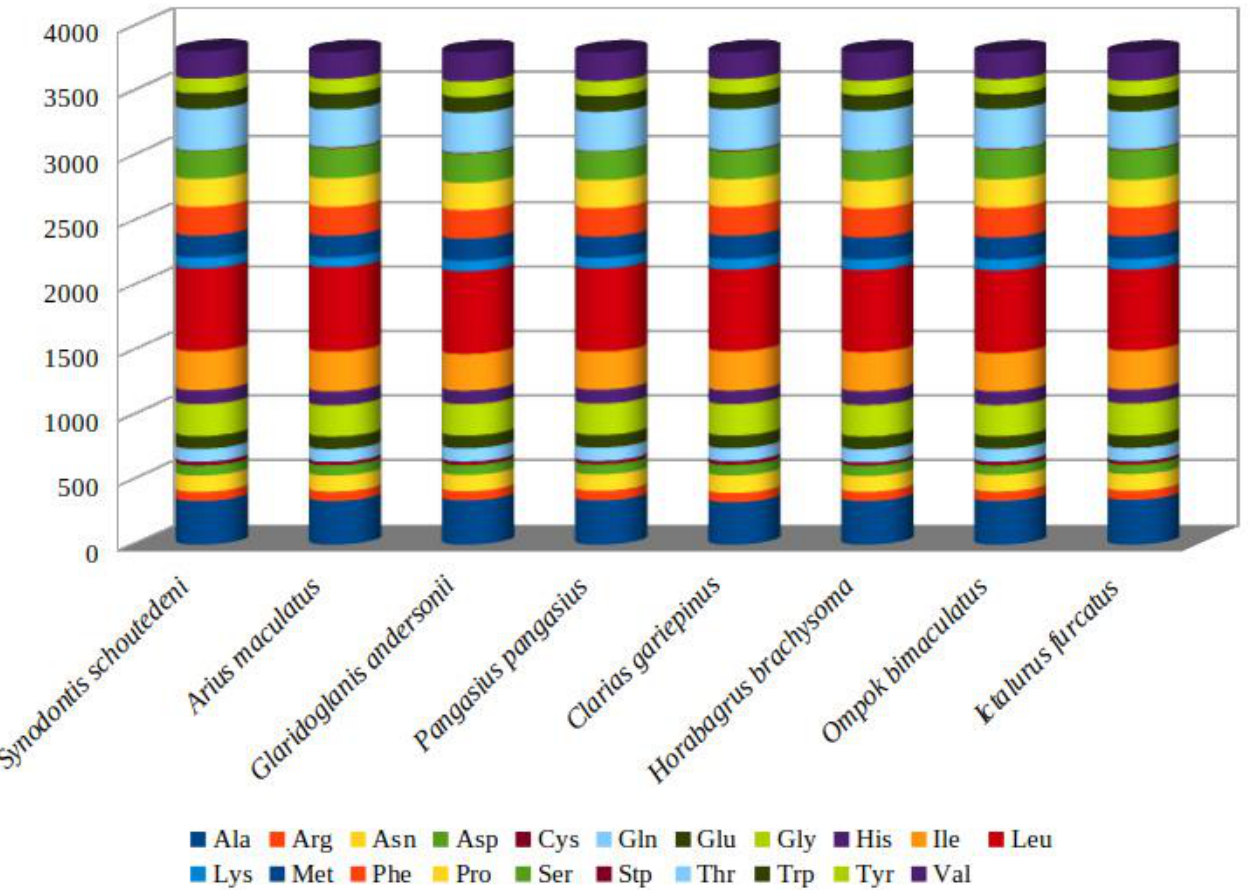
Figure 2. Comparison of codon usage within the mtDNA of members of the Siluriformes. Species (A. maculatus, Pangasius, Horabagrus brachysoma, Synodontis schoutedeni, Clarias gariepinus, Ictalurus furcatus, Ompok bimaculatus, and Glaridoglanis andersonii) represent the superfamily to which the species belongs (Ariidae, Pangasiidae, Bagridae, Mochokinae, Clariidae, Ictaluridae, Siluridae, and Sisoridae).